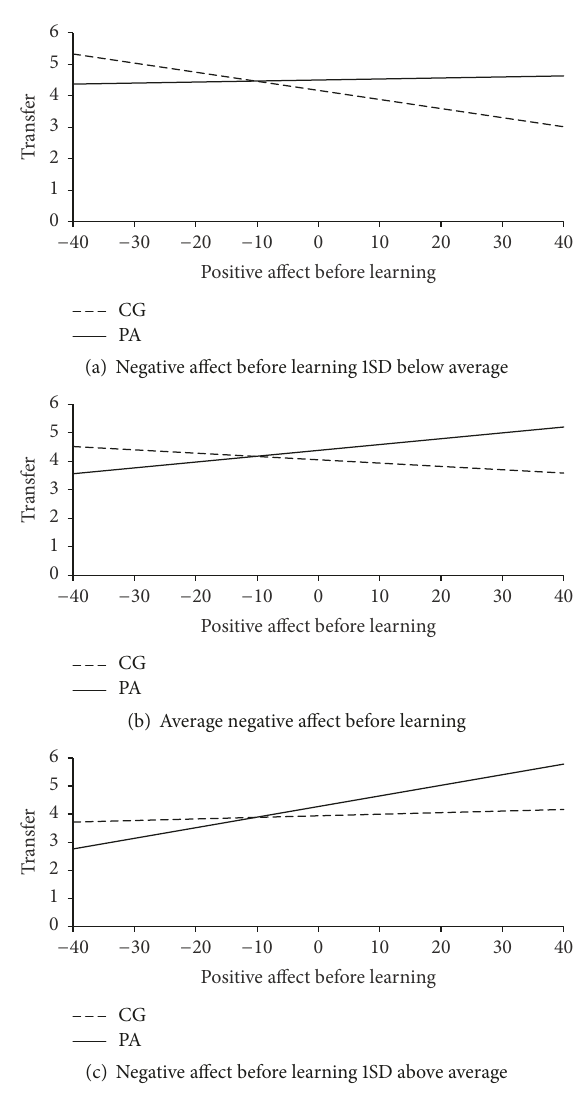
Figure 3: Regression of transfer on positive affect before learning for the positive affect group (PA) and the control group (CG) at three different levels of negative affect before learning. Positive and negative affect were